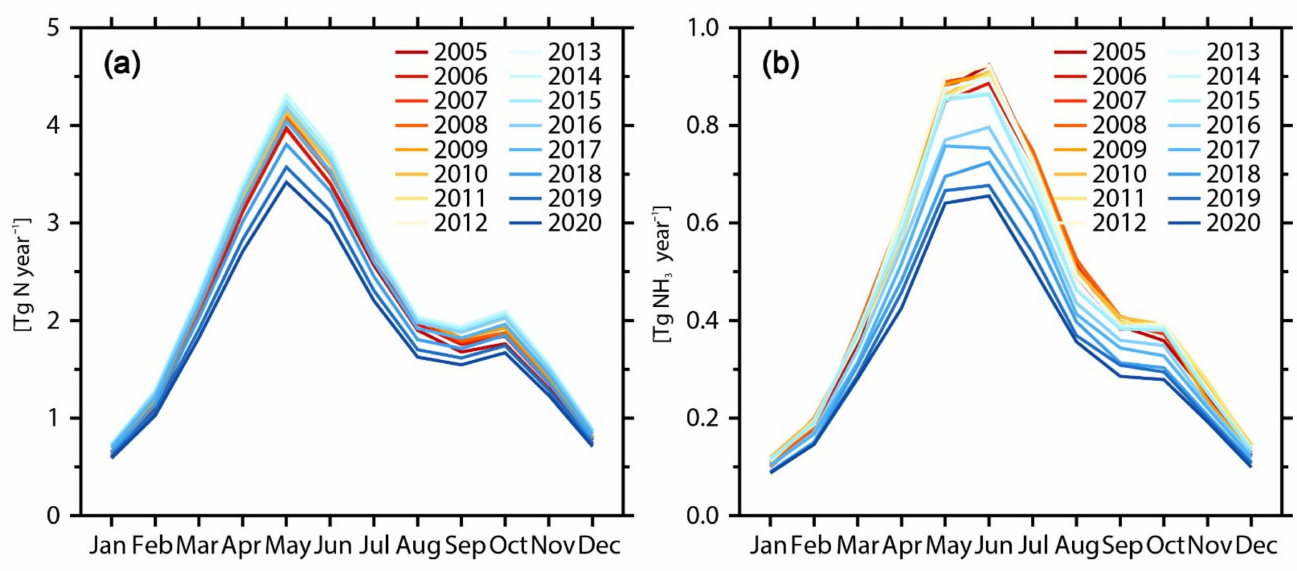
Figure 6. Monthly variations of ( a ) synthetic nitrogen fertilizer and ( b ) resulting NH 3 emissions from 2005 to 2020 in